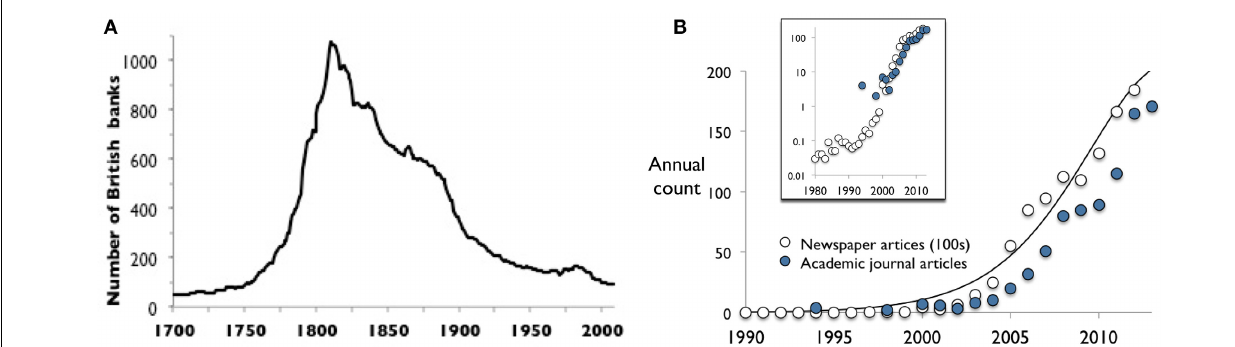
FIGURE 2 | Time scales of social tipping points. (A) The changing population of British banks from 1700 to 2009. Prior to 1810 the bank population increased by 2.7% annually. Post 1810 the population went into a systematic decline of approximately 1.2% per year for the next 200 years (Garnett et al., in press). (B) The popularity of “tipping points.” The number of English-language newspaper (LexisNexis